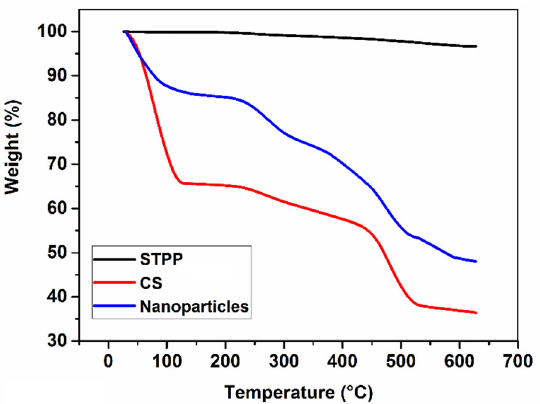
Figure 6. TGA thermograms of chitosan (CS), sodium tripolyphosphate (STPP), and CS nanoparticles (CSNPs).